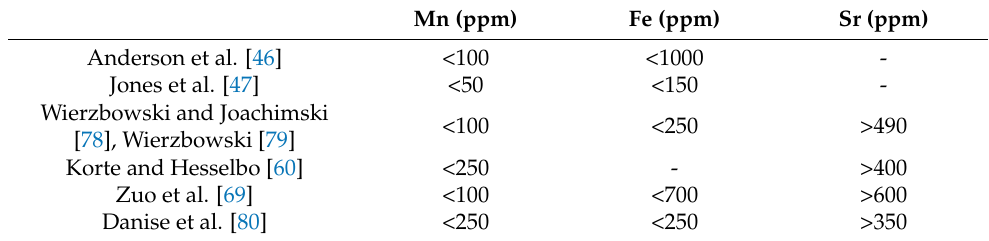
Table 3. Published threshold limits of element concentrations in well-preserved oyster